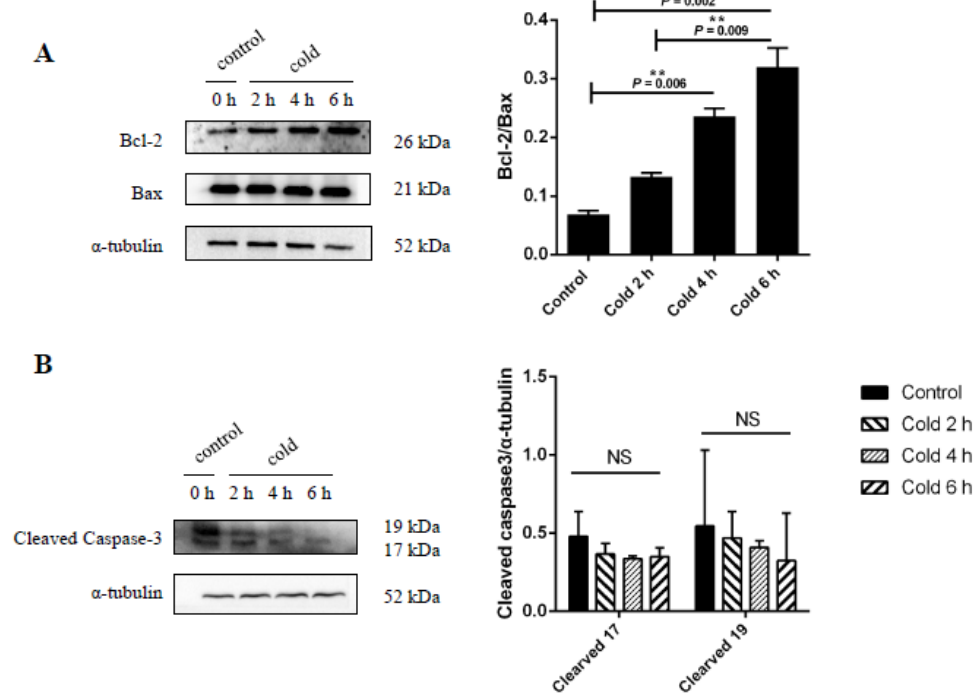
Figure 6. Effect of acute cold stress on the expression of ( A ) Bcl-2, Bax, and ( B ) caspase-3 proteins in the liver. The data are presented as mean ± SEM ( n = 8). Statistically significant differences are indicated, ** p < 0.01. NS: not significant.